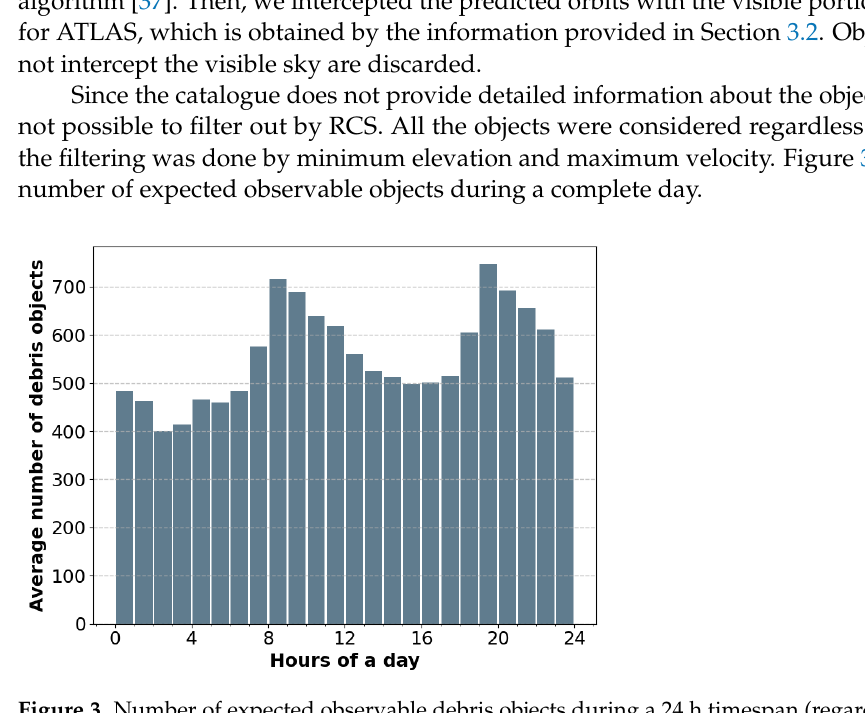
Figure 3. Number of expected observable debris objects during a 24 h timespan (regardless of